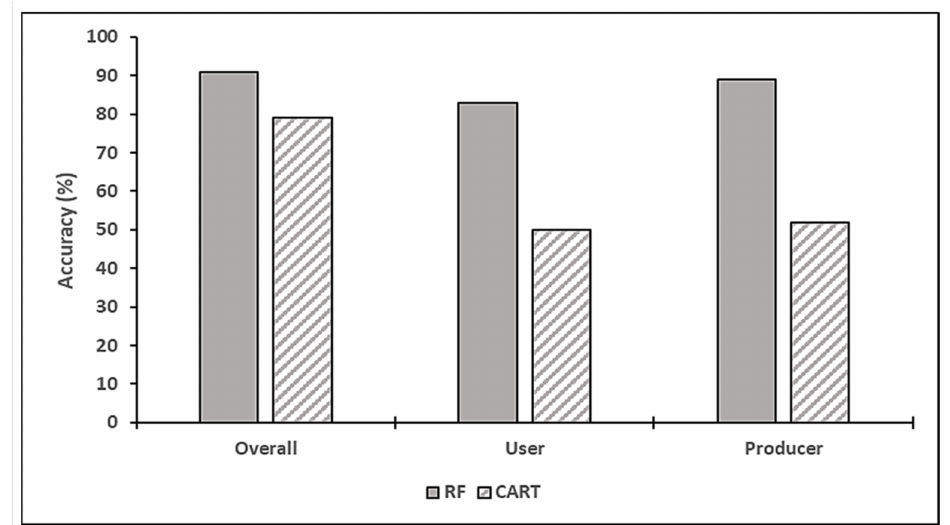
Figure 5. Classification results for discriminating nitrogen-saturated vs. -unsaturated grassland plots, where RF = Random Forest, and CART = Classification and Regression Tree analysis.